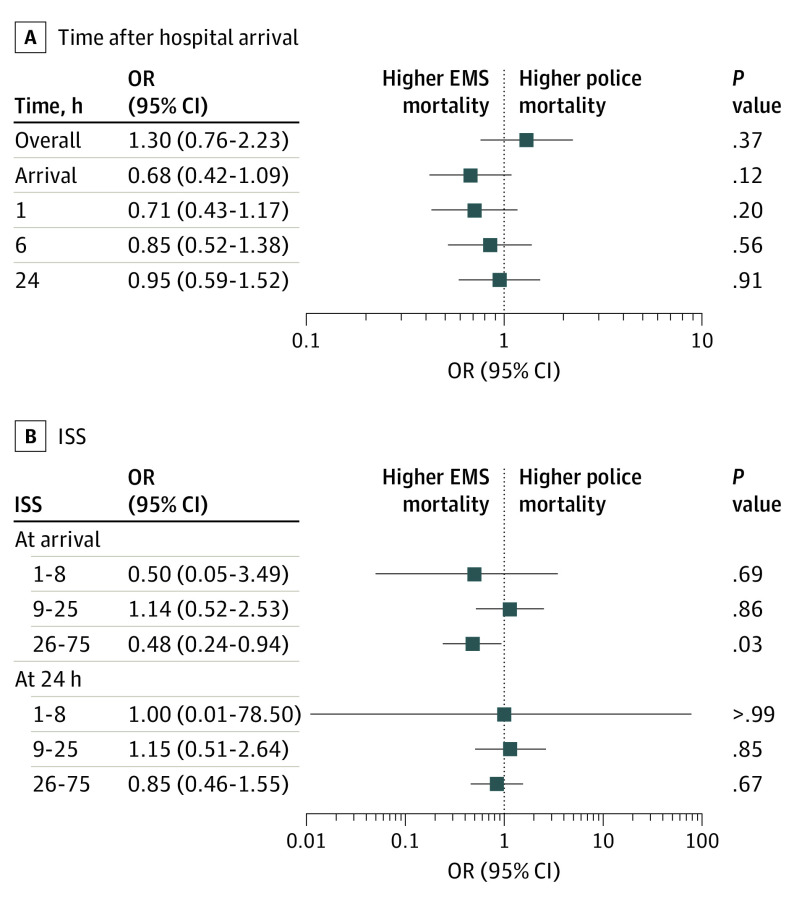
Matched Cohort OutcomesA, Odds ratios (ORs) and 95% CIs for matched cohort patient outcomes at several different time points after trauma center arrival. B, ORs and 95% CIs for matched cohort patient outcomes with different Injury Severity Scores (ISS) at several different time points after trauma center arrival.